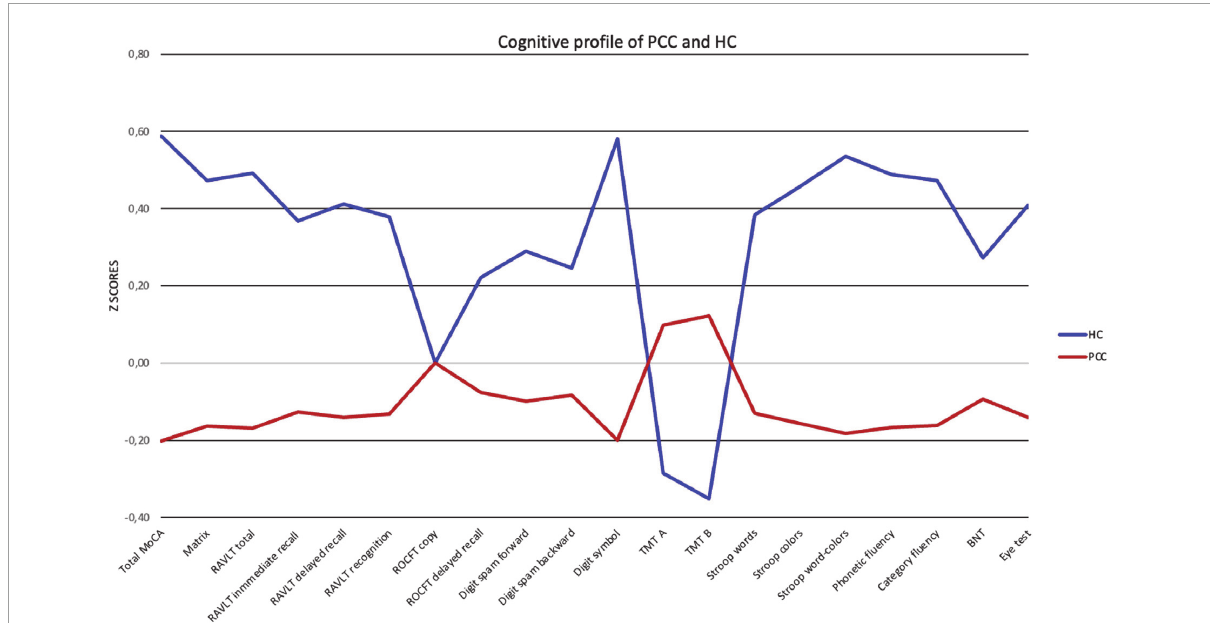
FIGURE1 Cognitive profile for PCC and HC. Healthy controls (HC) in blue, PCC in red. Data are presented as Z -scores. Lower Z -scores indicate poorer performance, except for TMT (time), where lower Z -scores mean better performance.